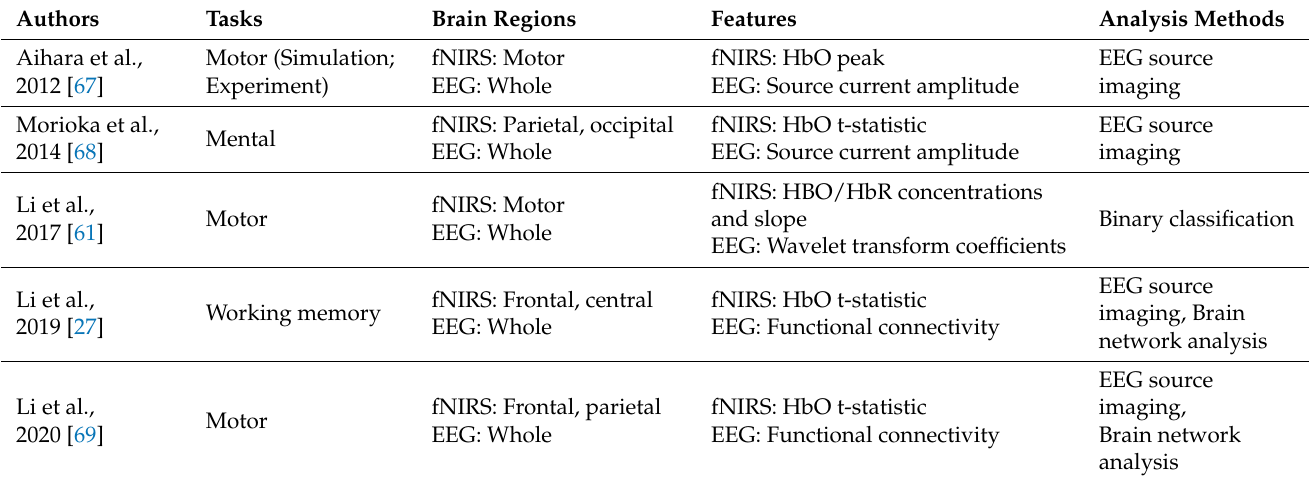
Table 2. Characteristics of studies performed fNIRS-informed EEG